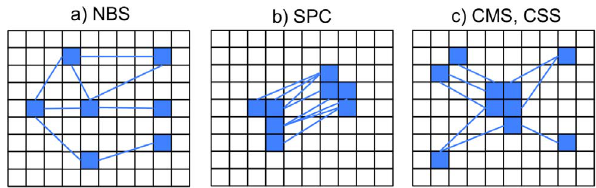
Figure 1. Connectivity clustering methods. Typical patterns of connectivity change that the different clustering methods are sensitive to. Here, squares represent voxels and lines represent thresholded connectivity changes. (a) NBS cluster size is defined by the number of thresholded connectivity changes forming continuously connected components. The NBS cluster above has an extent of eight. (b) SPC cluster size is defined by the number of thresholded connectivity changes forming pairwise spatial clusters. The SPC cluster above has an extent of eight. (c) CMS size is defined by the total number of connectivity changes between a spatially distinct cluster, and the rest of the brain. The CMS cluster above has an extent of eight. CSS size is defined by the spatial extent of a cluster, where each voxel in the cluster exhibits at least one connectivity change with another voxel in the brain. The CSS cluster above has an extent of